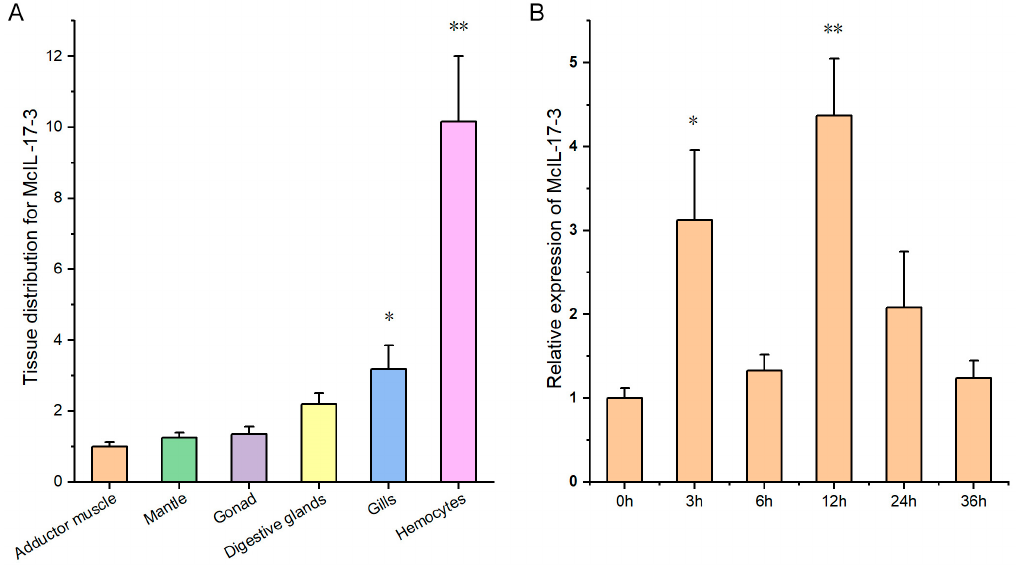
Figure 3. Expression profile analysis of Mc IL-17-3 transcripts. ( A ) Distribution of Mc IL-17-3 tran- scripts in common mussel tissues. ( B ) Temporal expression changes of Mc IL-17-3 transcripts in re- sponse to V. alginolyticus challenge. The results were expressed as mean ± SD ( n = 3, * p < 0.05, ** p < 0.01). (For interpretation of the references to color in this figure legend, the reader is referred to the Web version of this article.).